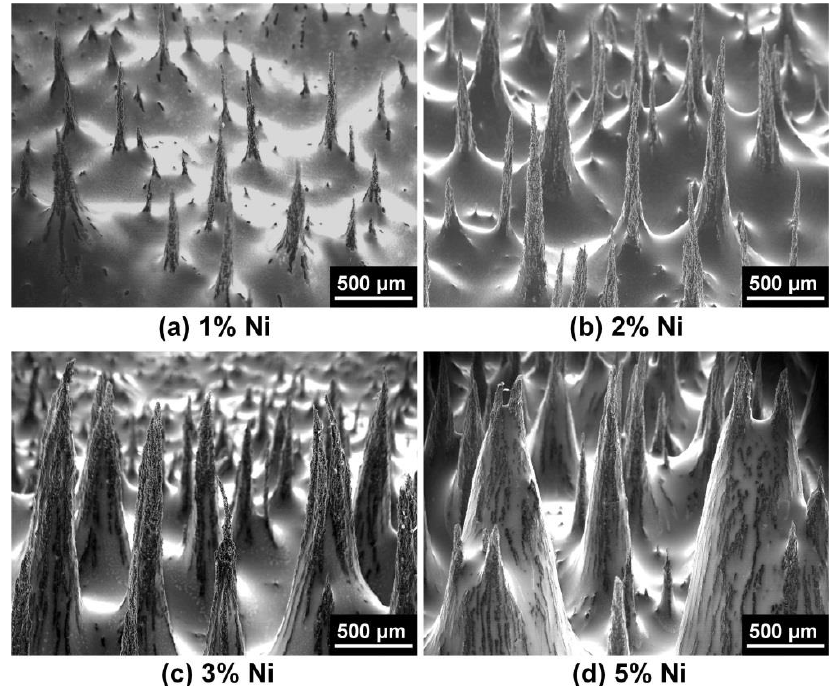
Figure 6. Typical array of vertical protrusive Shape Memory Polymer / Nickel (SMP / Ni) chains with varied volume fraction of nickel particles: 1%, 2%, 3%, and